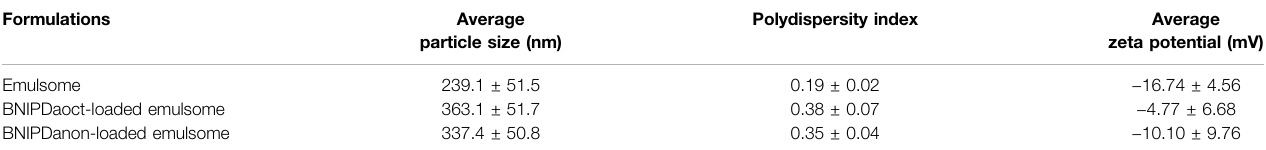
TABLE 1 | The average particle size, polydispersity index, and average zeta potential values for BNIPDaoct- and BNIPDanon-loaded emulsomes. Formulations